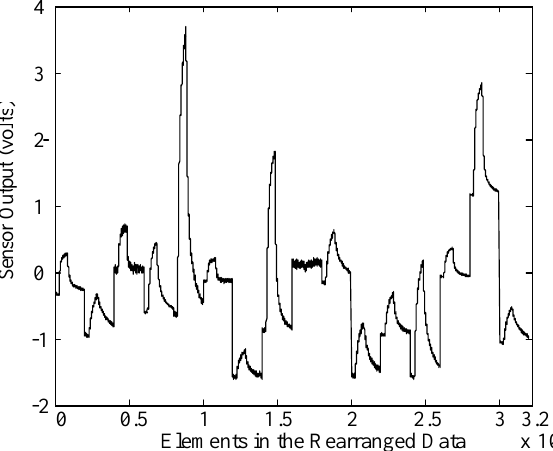
Figure 3. Data sample that is transformed into a 32,000 dimensional vector form.